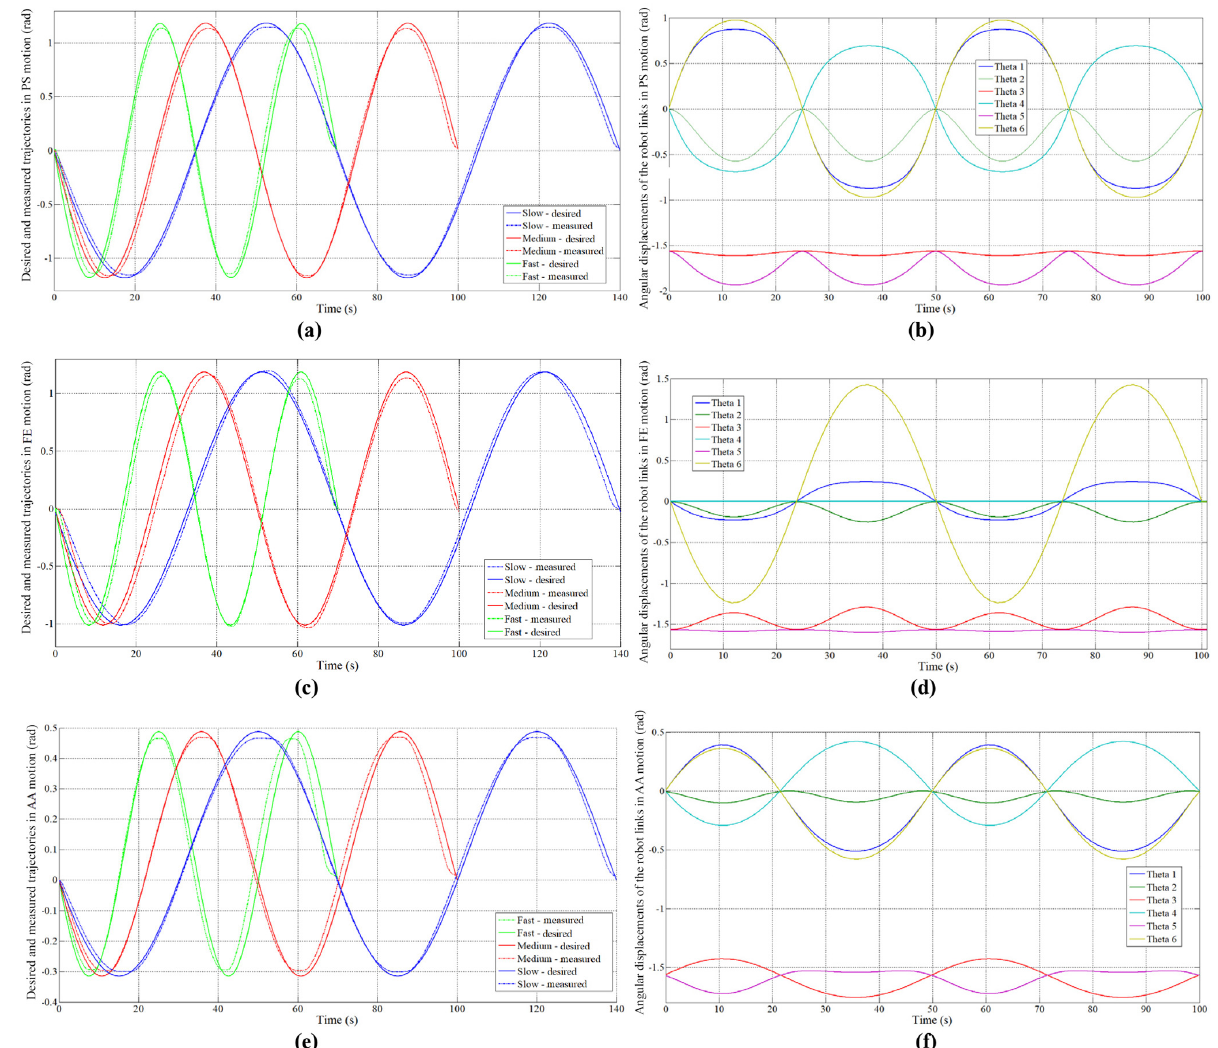
Figure 17. Measured trajectories and angular displacements of the robot links.